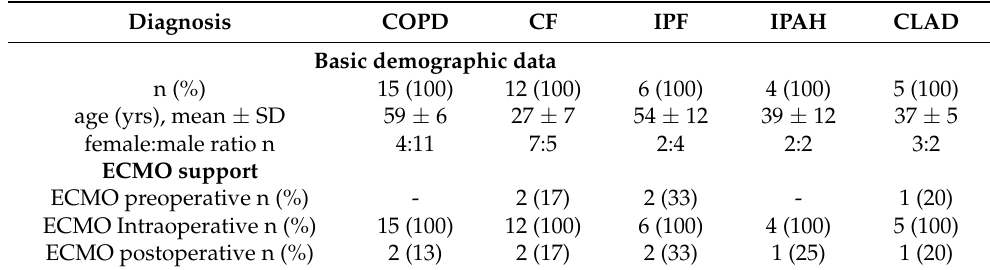
Table 1. Basic demographic data. Demographics and clinical data according to indication for LUTX are detailed